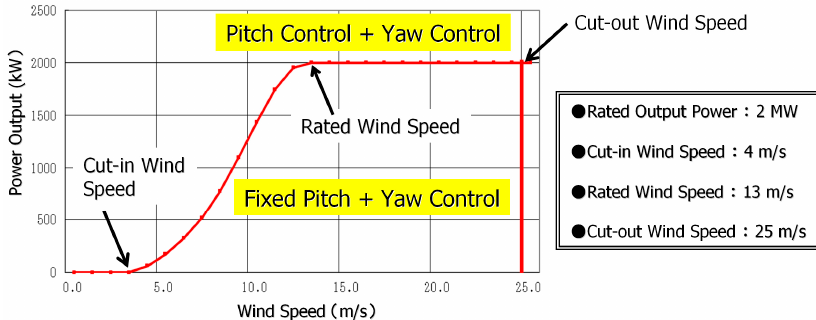
Figure 4. Outline of a wind turbine.